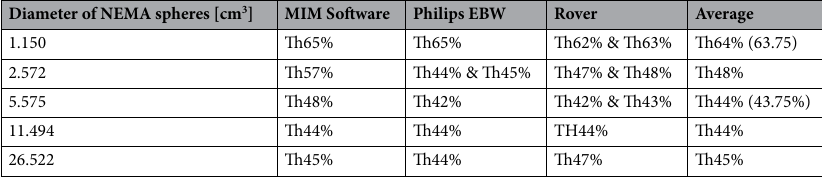
Table 6. Average cut-off Th based on NEMA phantom